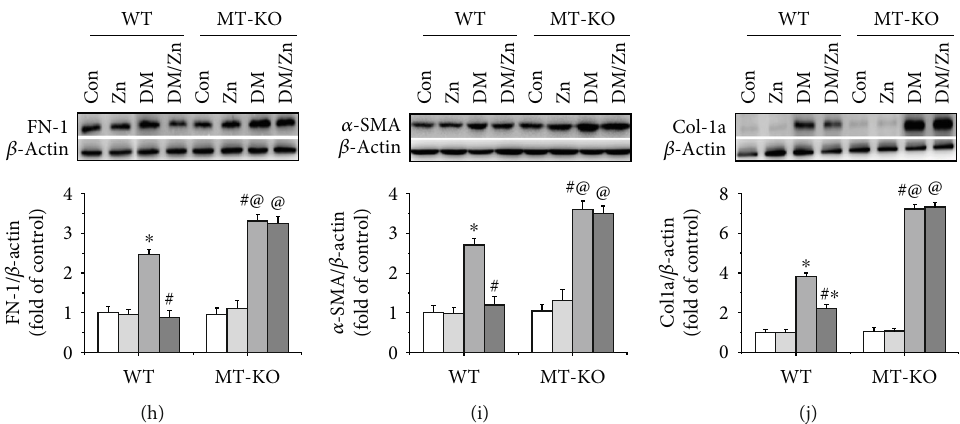
Figure 5: The e ff ect of zinc supplementation on type 2 diabetes-induced in fl ammatory response and fi brosis. Hepatic expression of in fl ammatory factors, including ICAM-1 (a), TNF- α (b), and PAI-1 (c), was examined by western blot. Hepatic collagen accumulation was examined by Masson staining (d, e). Hepatic fi brosis was examined by western blot for the expression of CTGF (f), TGF- β (g), FN-1 (h), α -SMA (i), and Col-1a (j). Data are presented as the mean ± standard deviation ( n = 8 /group). ∗ P < 0 : 05 vs. the control (Con) group in WT mice; # P < 0 : 05 vs. the type 2 diabetes (DM) group in WT mice; @ P < 0 : 05 vs. the control (Con) group in MT-KO mice. Con